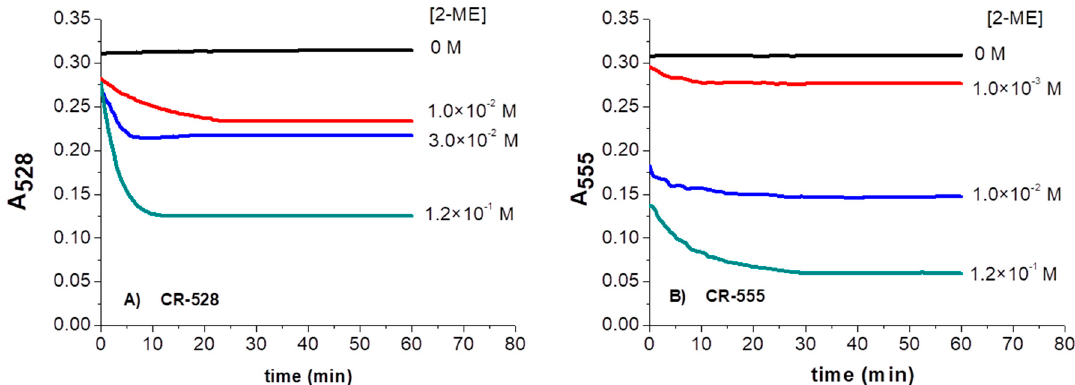
Figure 5. Time-courses of CR-528 (2.4 × 10 − 7 M; ( A )) and CR-555 (2.6 × 10 − 7 M; ( B )) in the presence of various concentrations of 2-ME (from 0 to 1.2 × 10 − 1 M) in ethanol solution, recorded at A 528 and A 555 , respectively.